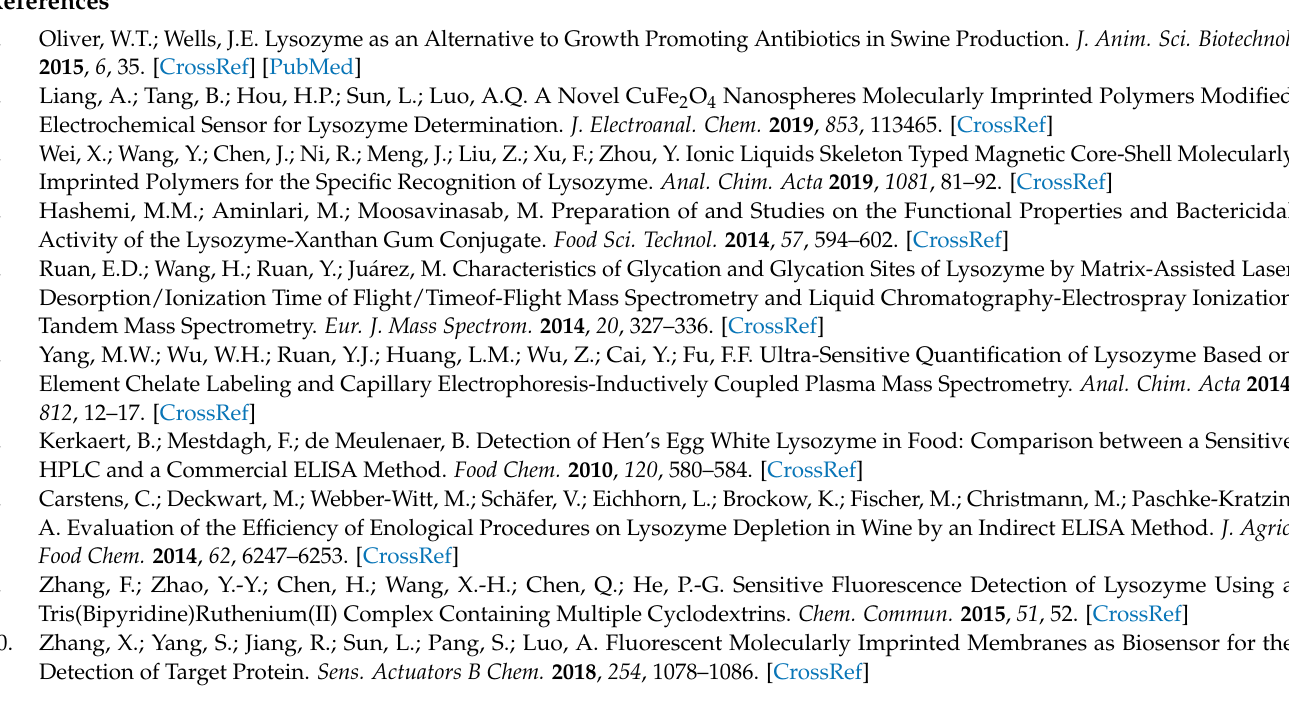
Table S1: Average data for equivalent circuit of MIPPy/GO@Fe 3 O 4 impedimetric